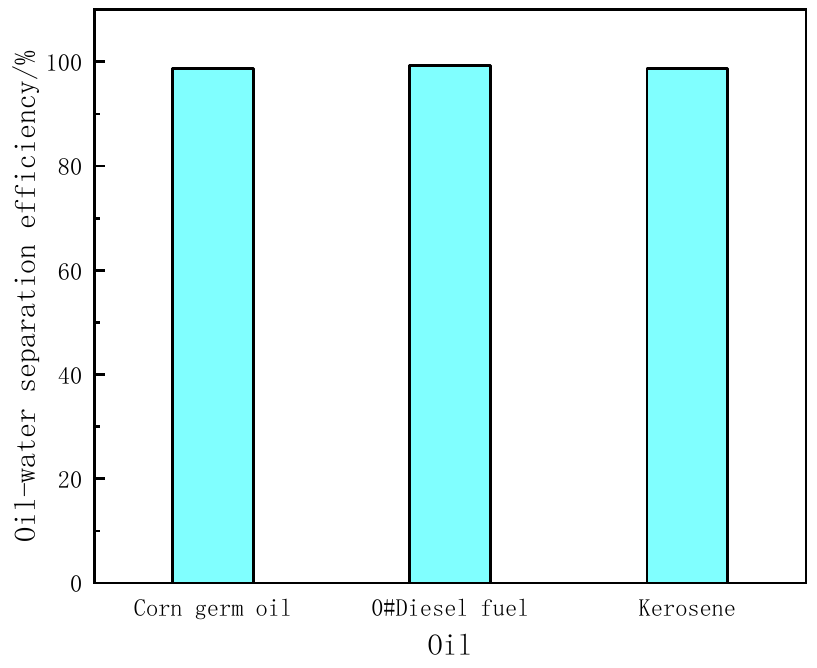
Figure 8. Separation efficiency of PDMS@Fe 3 O 4 /MS for different oil ‐ water mixtures.